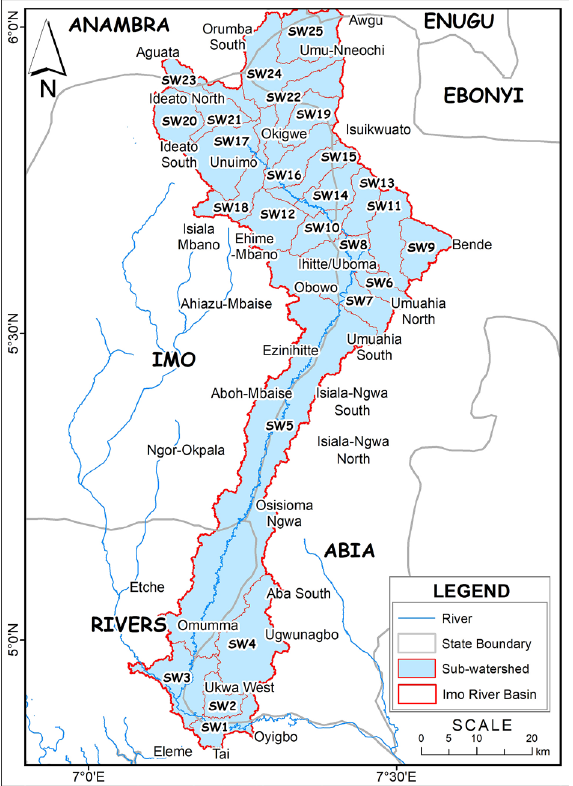
Fig. 3. Sub-watershed map of Imo River Basin. Fig. 4. Drainage map of Imo River Basin showing the